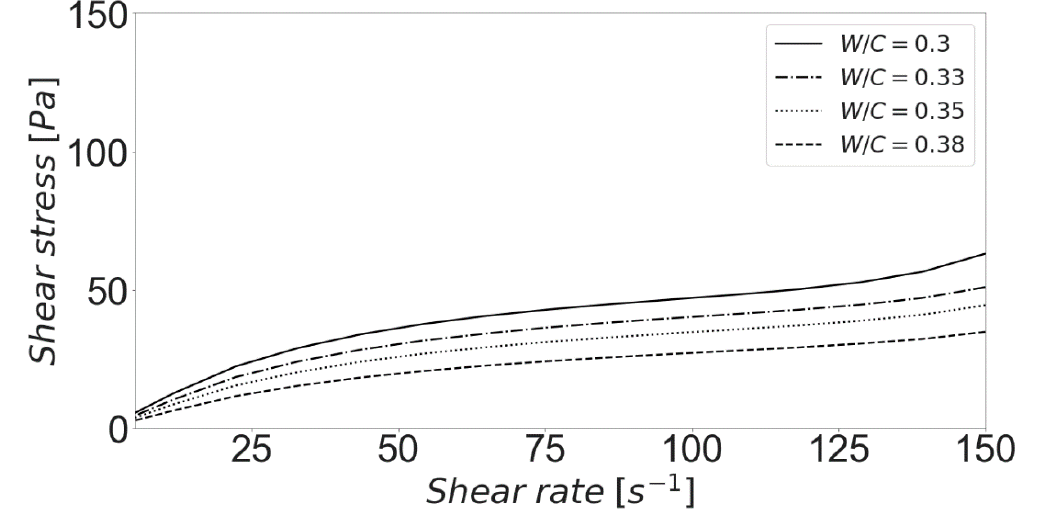
/ C) on the predicted flow